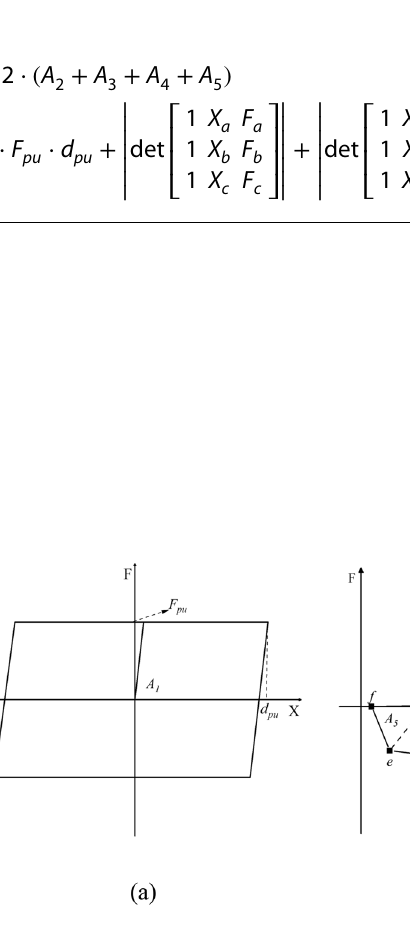
Fig. 13 Geometric partitions of modelled hysteretic loop for area